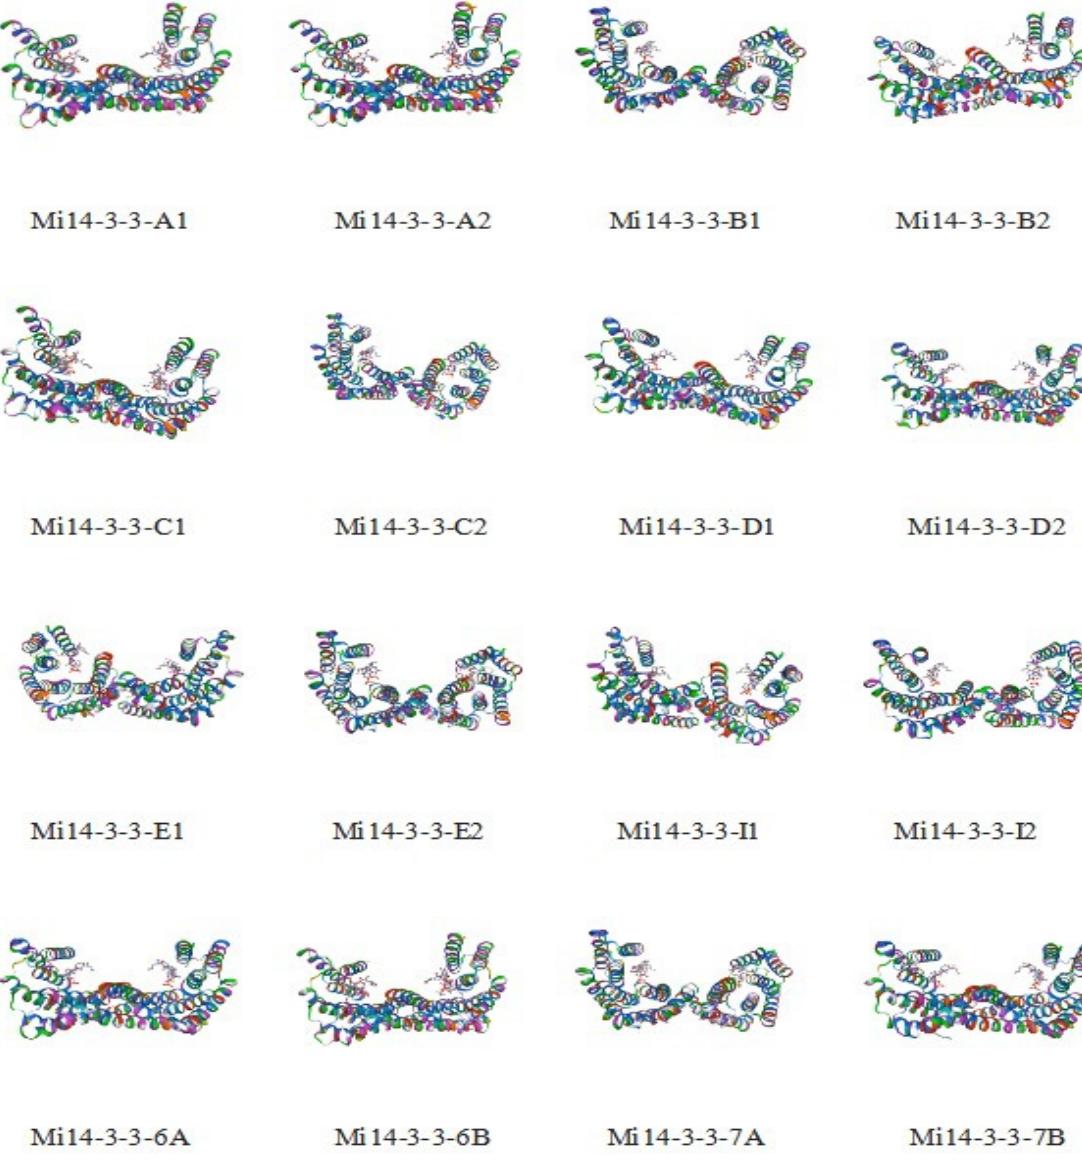
Figure 1. Tertiary structures of Mi14-3-3 proteins.